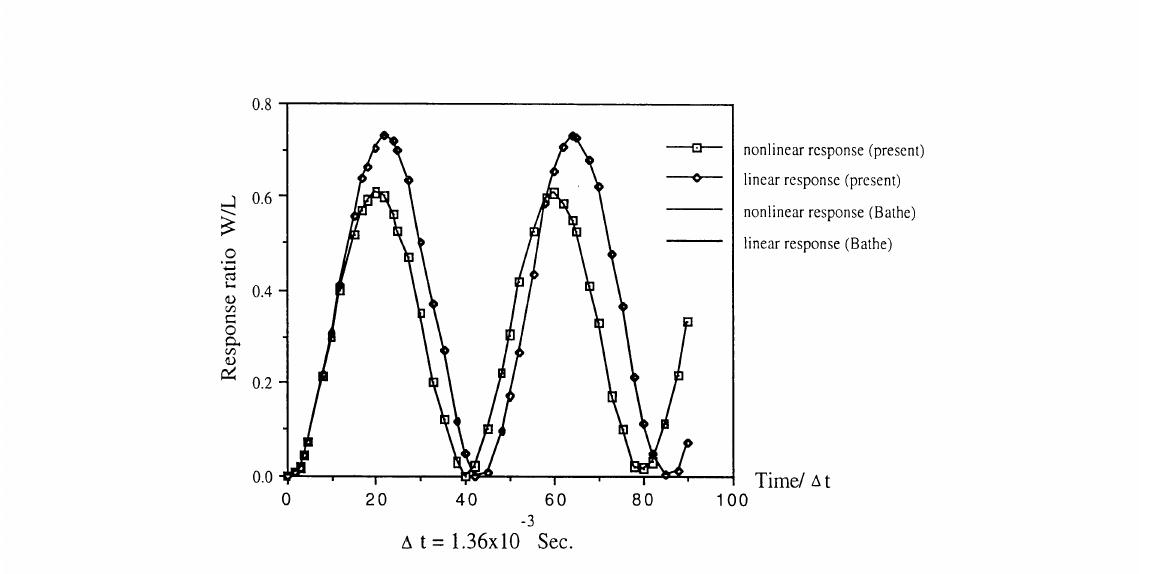
FIGURE 3 Comparison of response of the cantilever to dynamic step